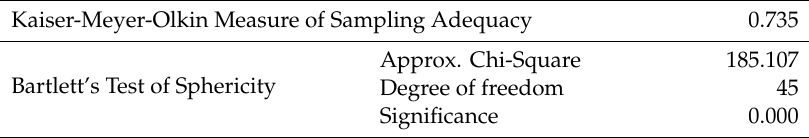
Table A2. Results of KMO and Bartlett’s Tests for the indicator of writer’s